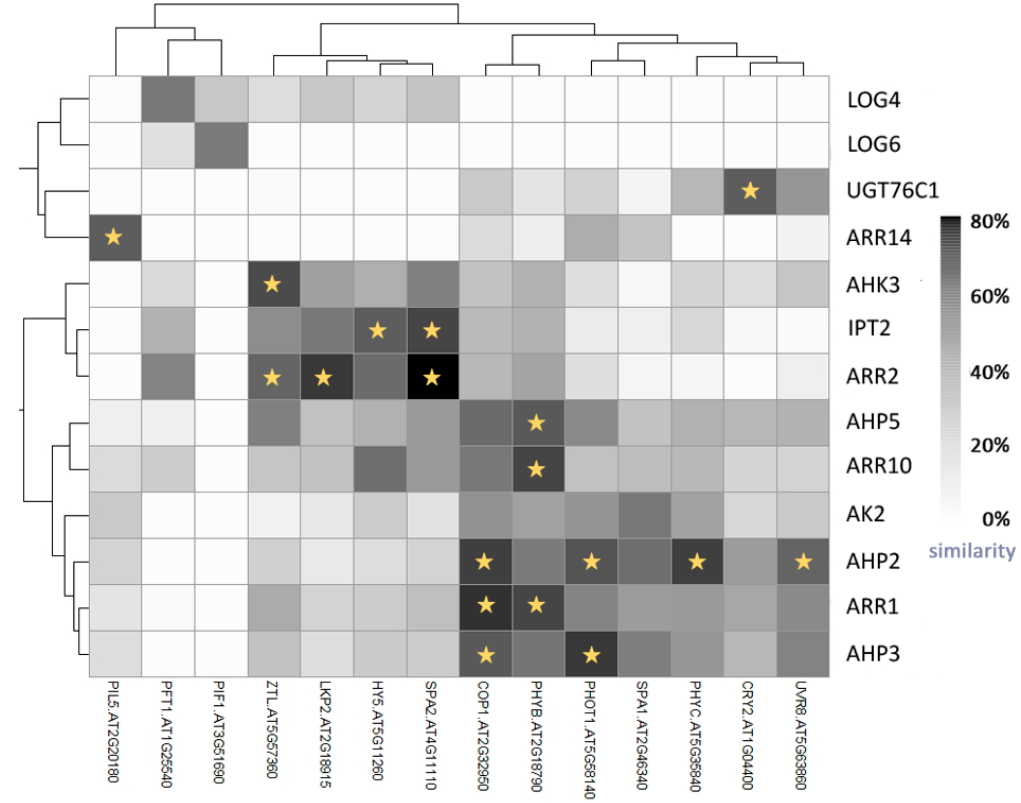
Figure 5. Heatmap showing degrees of similarity between expression profiles of cytokinin (signalling and metabolism) genes and genes involved in light perception. The heatmap was generated using R software and data available from Araport [33]. Asterisks indicate >70% similarity.